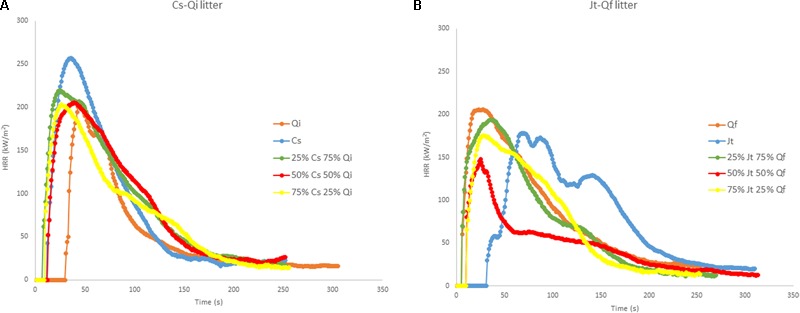
Heat release rate (HRR) curves (MLC tests at 50 kW/m2) of reconstructed litter of constant bulk density (20 kg/m3): (A) pure C. sempervirens (Cs) and Q. ilex (Qi), and mixtures of Cs-Qi; (B) pure J. thurifera (Jt) and Q. faginea (Qf) and mixtures Jt–Qf. The tests with mixtures were carried out with three different proportions of the two mixed species (25/75; 50/50; 75/25).